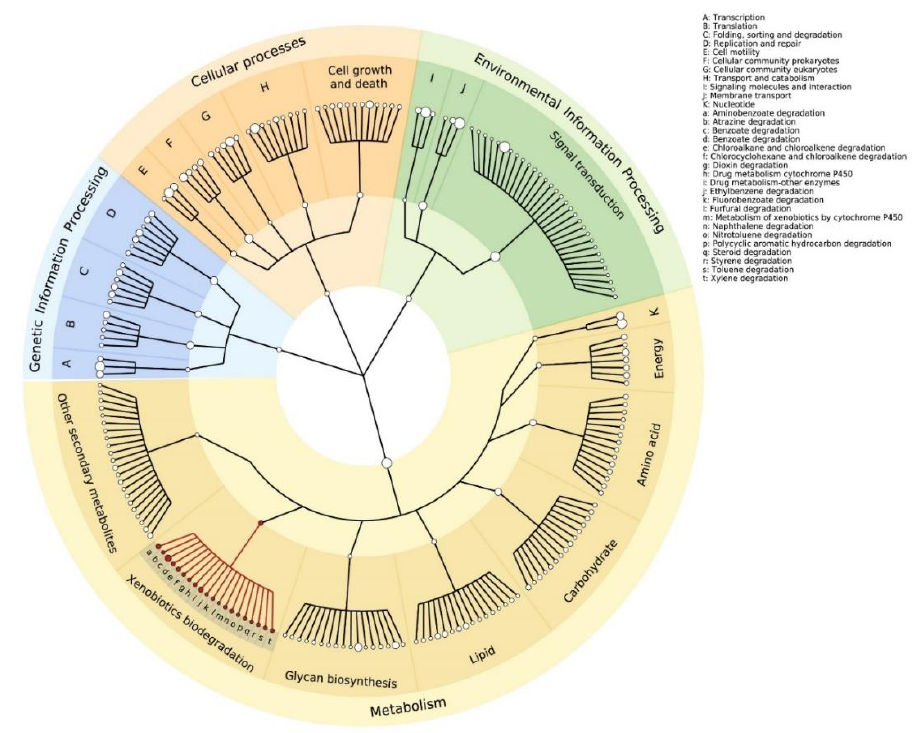
Figure 3. Abundance based cladogram of the KEGG molecular functions assigned to the predicted protein expression for all sampled sites. Xenobiotics biodegradation pathways found in the sites are in red and legend-specified in lowercase letters. The size of the nodes correlates with the abundance of annotated sequences for each pathway.